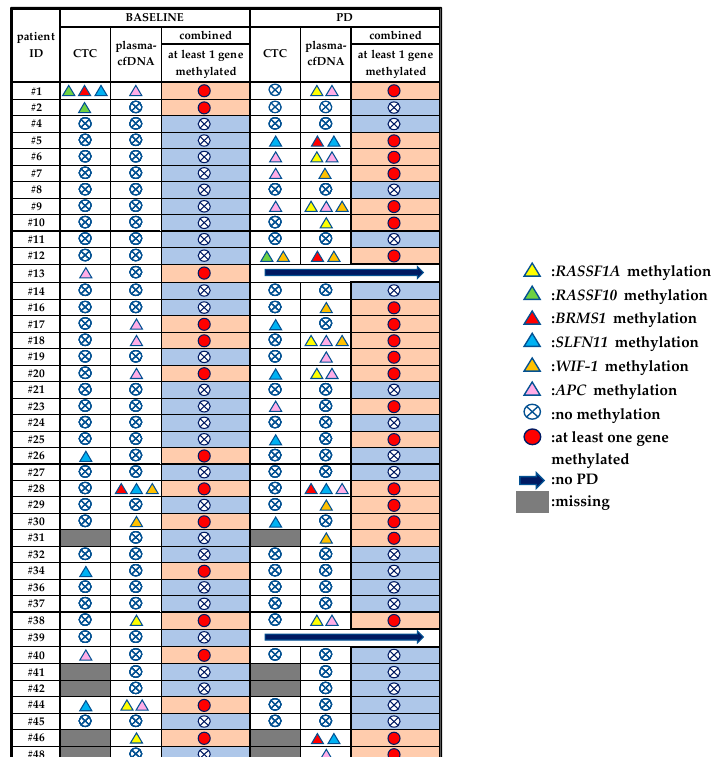
Table 1. DNA methylation status in cfDNA and/or CTCs in respect to time ‐ to ‐ progression.